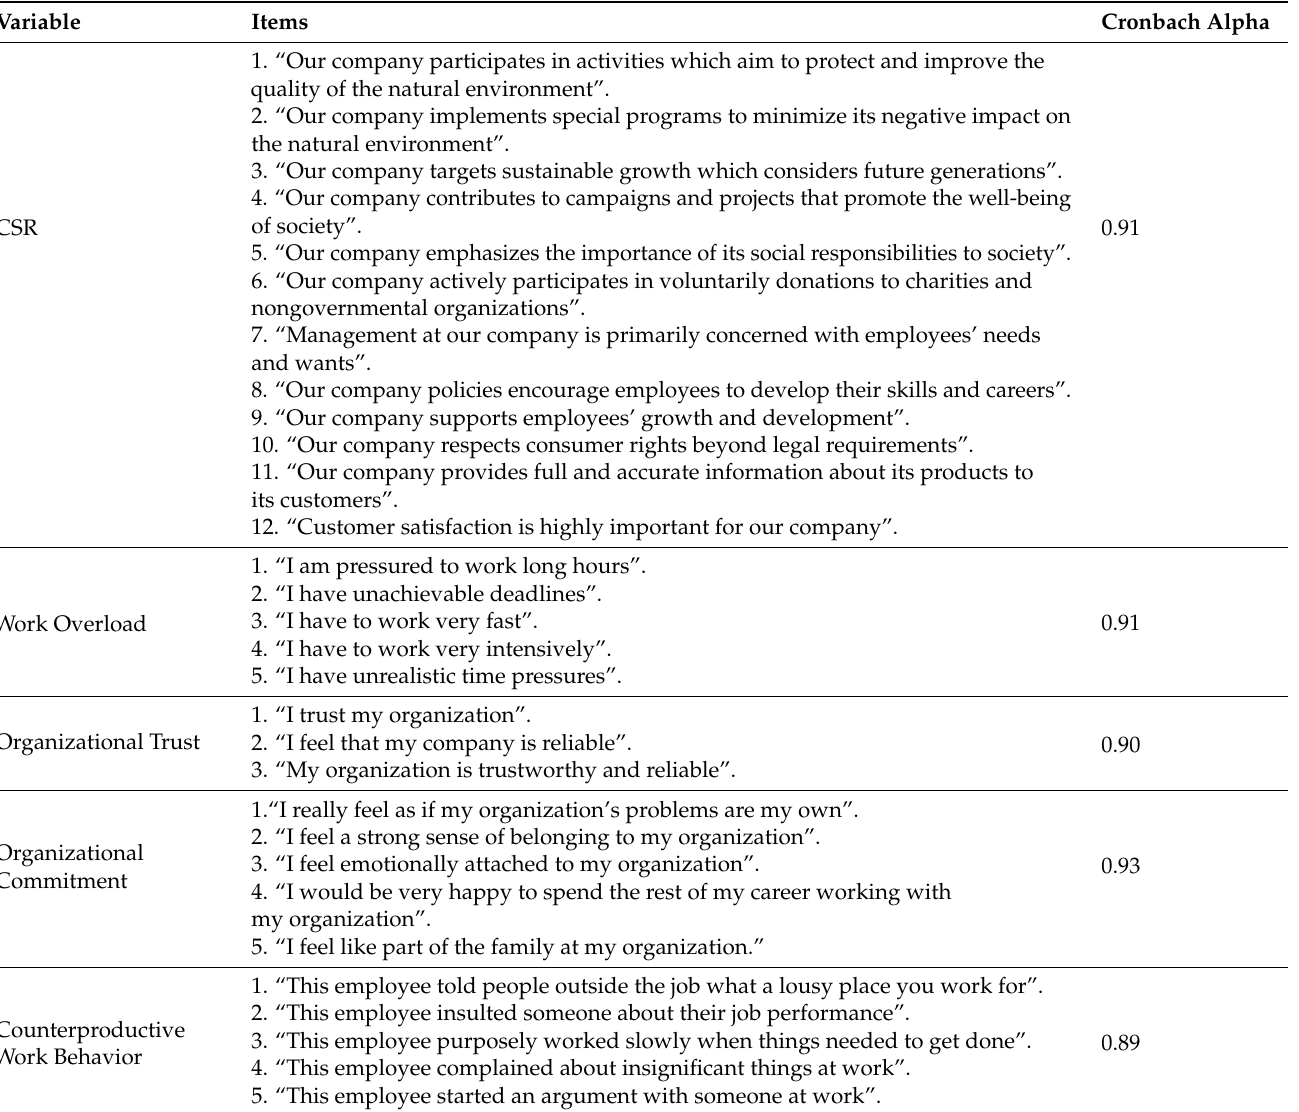
Table A1. The Items and the Value of Cronbach Alpha of Each